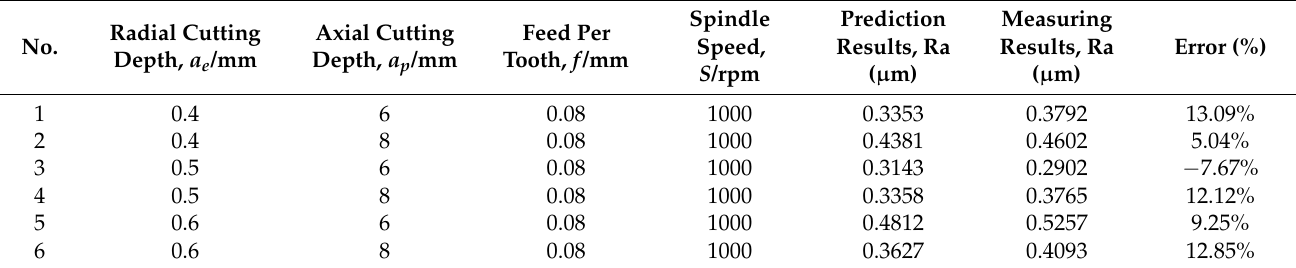
Table 2. Comparison of simulation and experimental results of surface roughness.